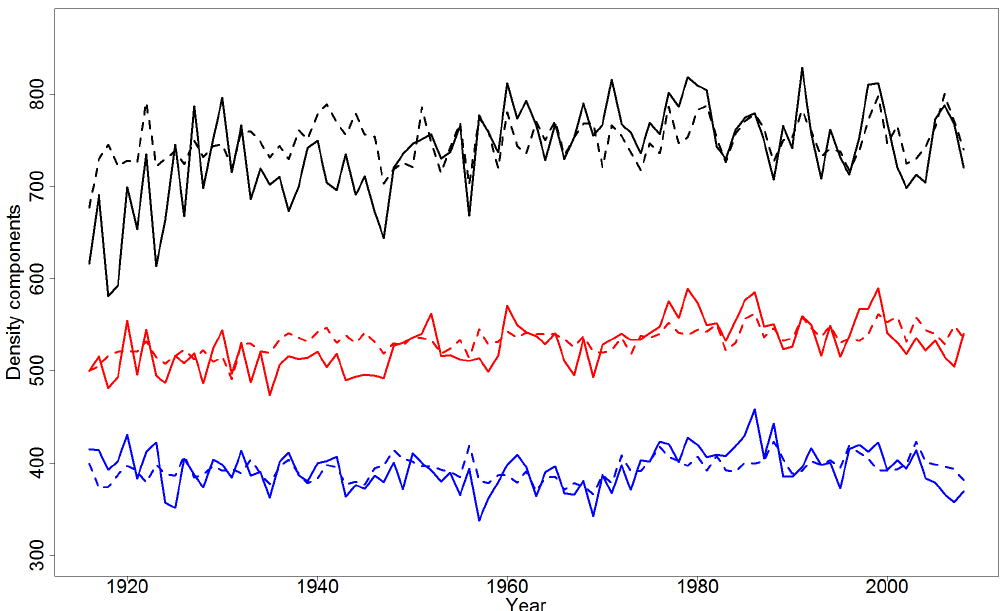
Figure 4. Ring density components (mean observed and predicted values) against calendar year for intermediate trees from 1915 to 2008. Observations were displayed by solid lines and predictions were depicted by dashed lines. Different density components are represented by the different colors, minimum ring density (blue lines); maximum ring density (black lines) and average ring density (red